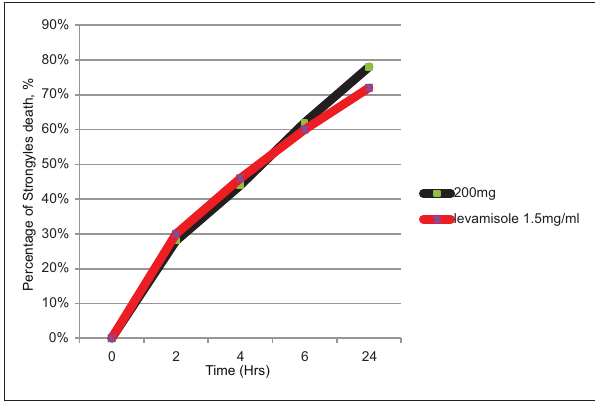
Figure-3: Comparison of larvae mortality at different hours following treatment with 200 mg/mL of ethanolic extract of tumeric and 1.5 mg/mL of